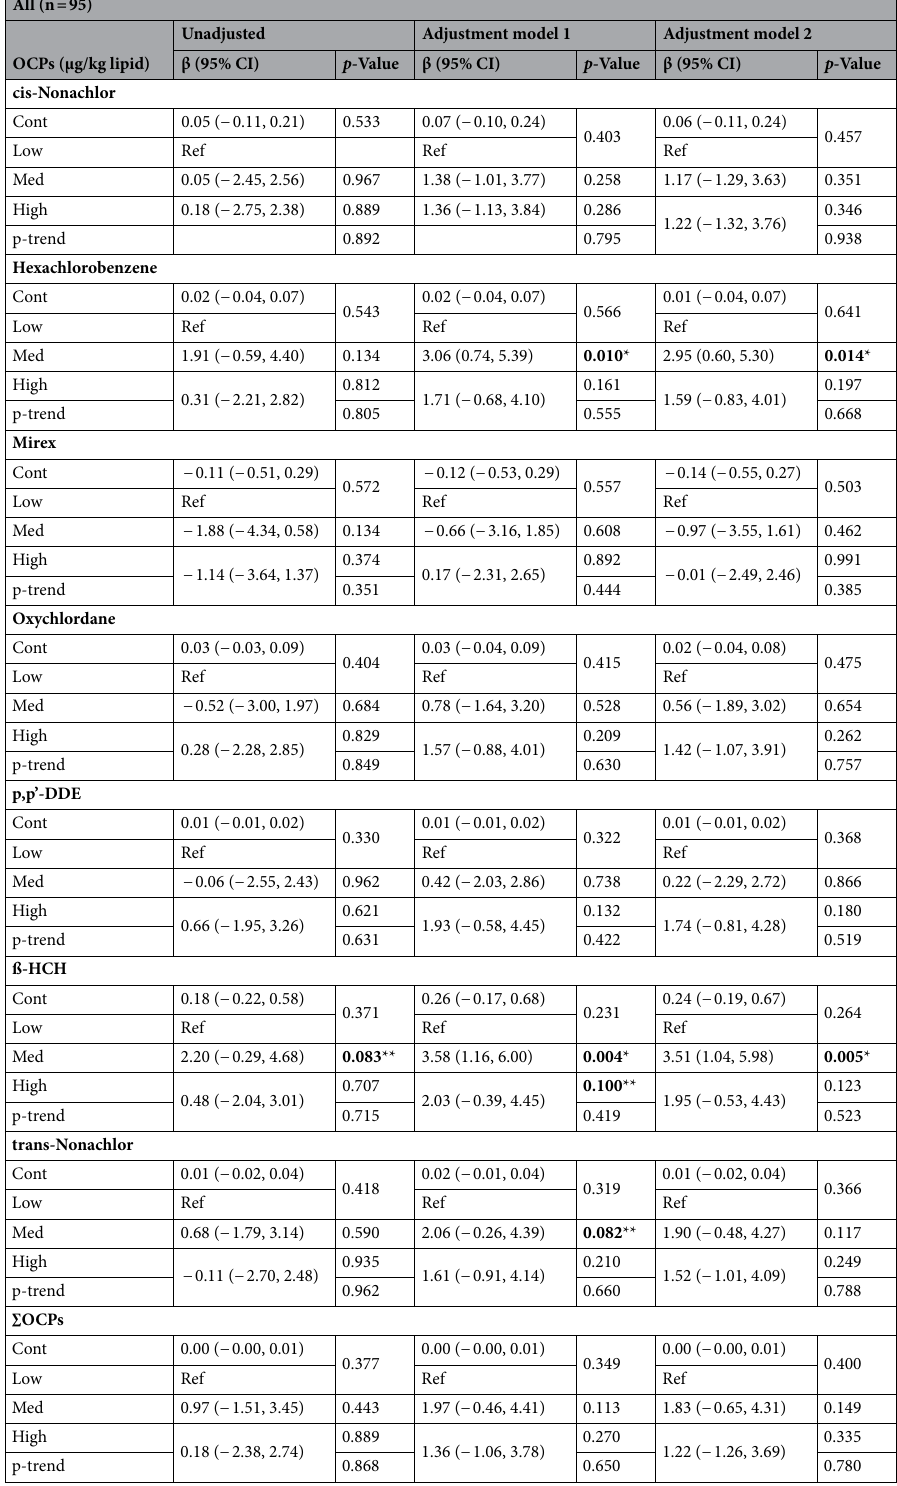
Table 4. Linear regression analysis of associations between prenatal OCP exposure and continuous SDQ score: Greenlandic children 3–5 years of age born 2014–2016 in the ACCEPT birth cohort. n Number of participants in parameter, β Linear regression coefficient in score points, CI confidence interval, Bold text and * = Significant ( p ≤ 0.050), Bold text and ** = Borderline significant ( p ≤ 0.100), Adjustment model 1: